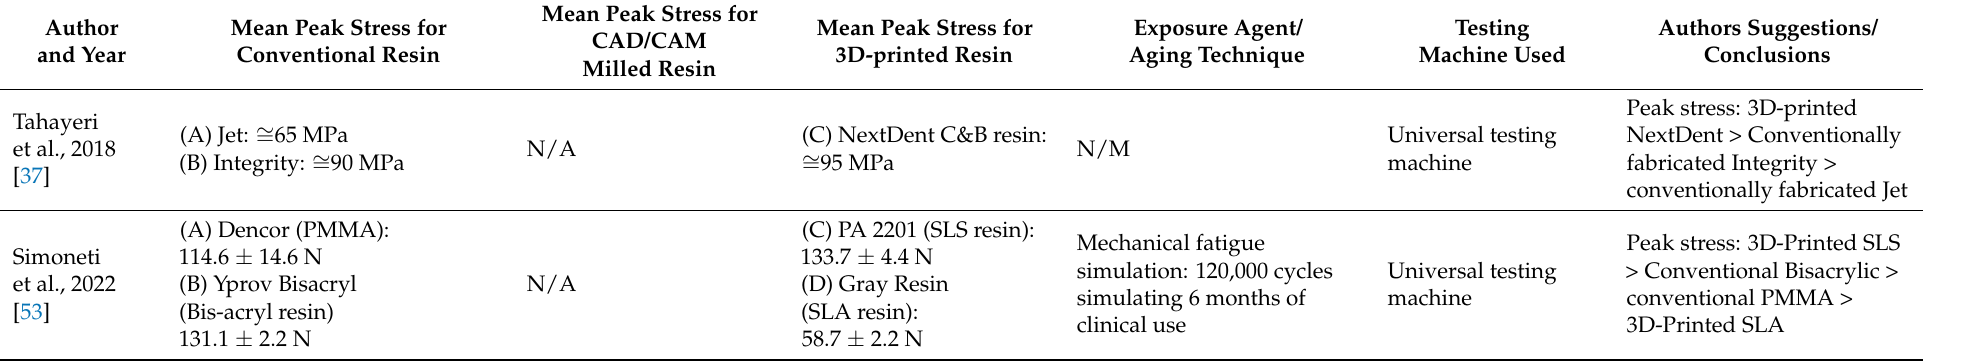
Table 14. Peak Stress Results.